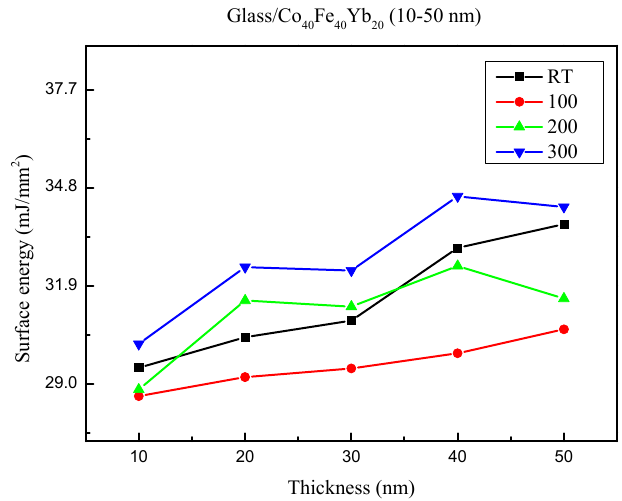
Figure 3. Surface energy of Co 40 Fe 40 Yb 20 thin films.